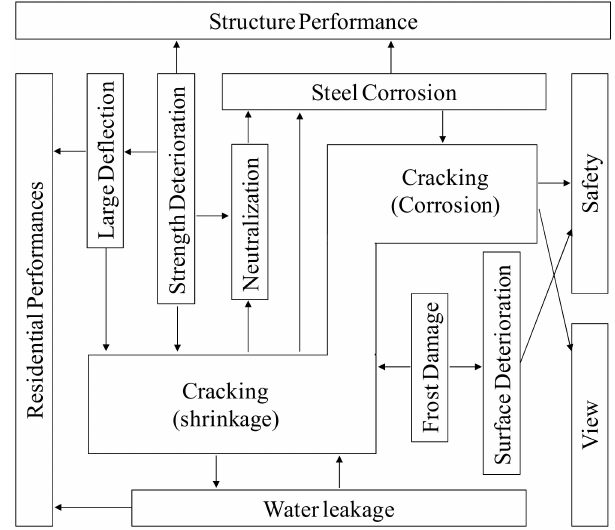
Figure 1. Correlation of degradation with